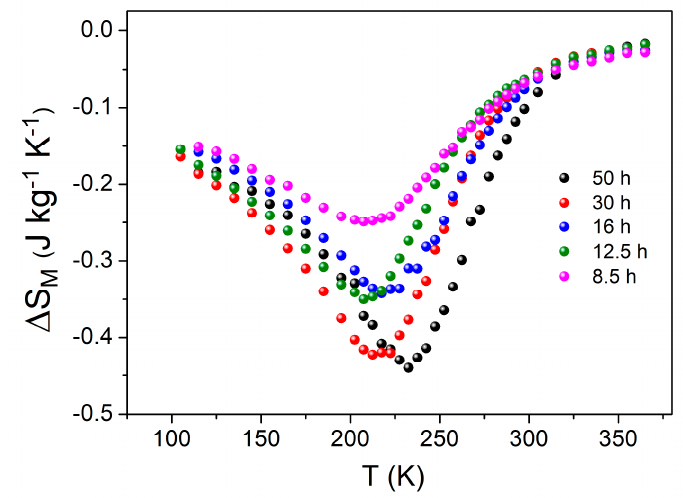
Figure 8. Magnetic entropy changes at µ 0 ∆ H = 1 T after correcting the demagnetizing field for samples after di ff erent times of milling.